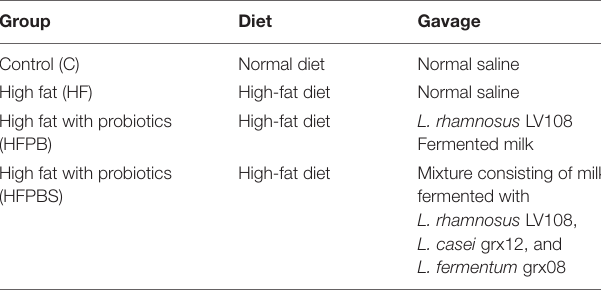
TABLE 1 | Animal groups and